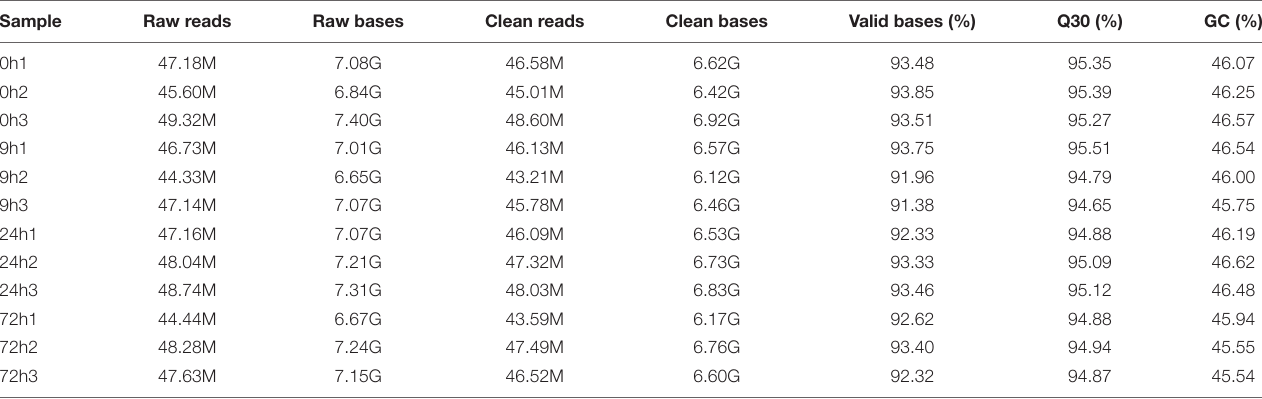
FIGURE 1 | The variation in 1-aminocyclopropane-1-carboxylic acid (ACC) content (A) , abscisic acid (ABA) content (B) , indole-3-acetic acid (IAA) content (C) , and salicylic acid (SA) content (D) in roots of Styrax tonkinensis seedlings under waterlogging stress after 0, 9, 24, and 72 h, respectively. Different lowercase letters within each graph indicate significant differences ( p < 0.05) among the samplings, whereas different capital letters within each graph indicate significant differences ( p < 0.01) among the samplings. FW, fresh weight. TABLE 2 | Statistic of raw data and clean data.